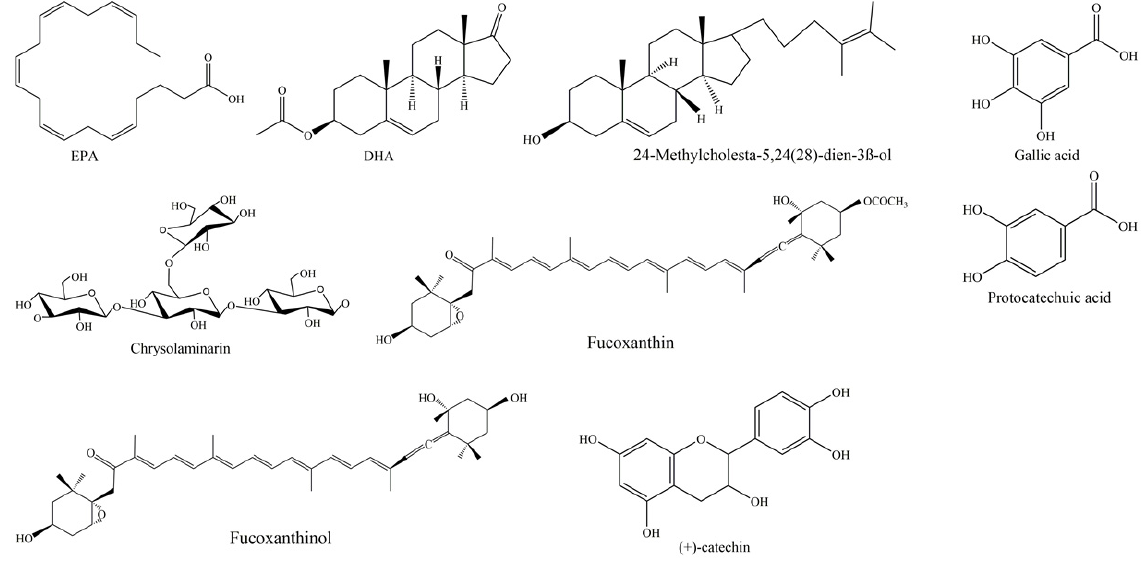
Figure 2. Chemical structures of the most significant molecules isolated from diatoms, drawn by using the software using the software ChemDraw.